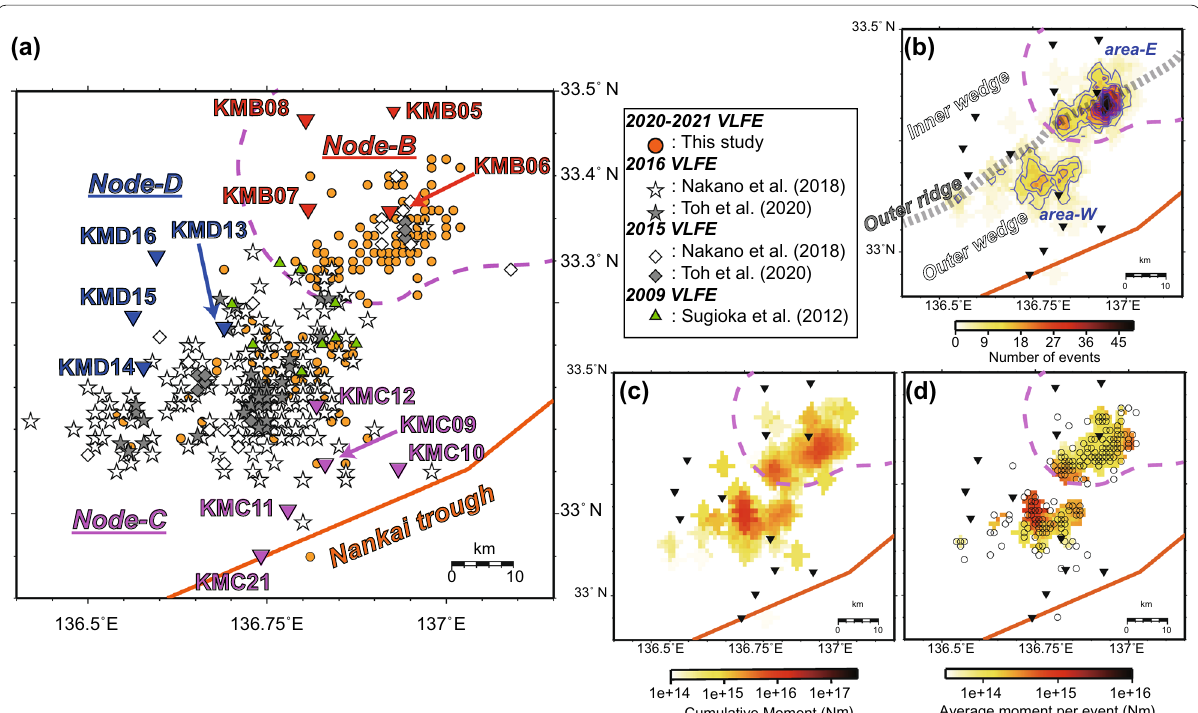
Fig. 2 Details of the sVLFE distribution. a Spatial distribution of the sVLFEs obtained in this and the previous studies. The DONET node and station codes are also shown. b Heatmap of the sVLFE activity for the entire episode. The background color and blue contours indicate the event number within 0.03° at each point. The contour interval is 5. The locations of the outer ridge, outer wedge, and inner wedge based on the bathymetry map are also shown. c Distribution of the cumulative moment release amount at each point. d Distribution of the moment release amount per event at each point. The open circles indicate the sVLFEs detected in this study. Note that only the areas where the event number within 0.03° larger than 5 are